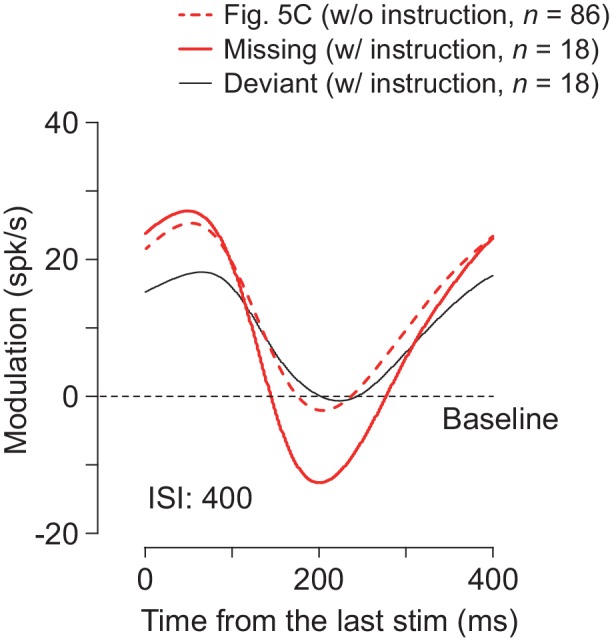
Effects of prior instruction of oddball condition on neuronal activity in the cerebellar dentate nucleus.Time courses of population activity aligned with the stimulus just before the oddball. Red dashed trace duplicates the data in Figure 5C, and were obtained in trials with no prior instruction about oddball condition (Ohmae et al., 2013). Red continuous trace plots the data in the explicit missing oddball condition, in which color of the fixation point (red) indicated the forthcoming stimulus omission (Figure 1A). Thin black trace indicates the data in the explicit deviant oddball condition (green FP). Data with prior instruction were obtained from the right dentate nucleus in monkey H (n = 18 neurons).